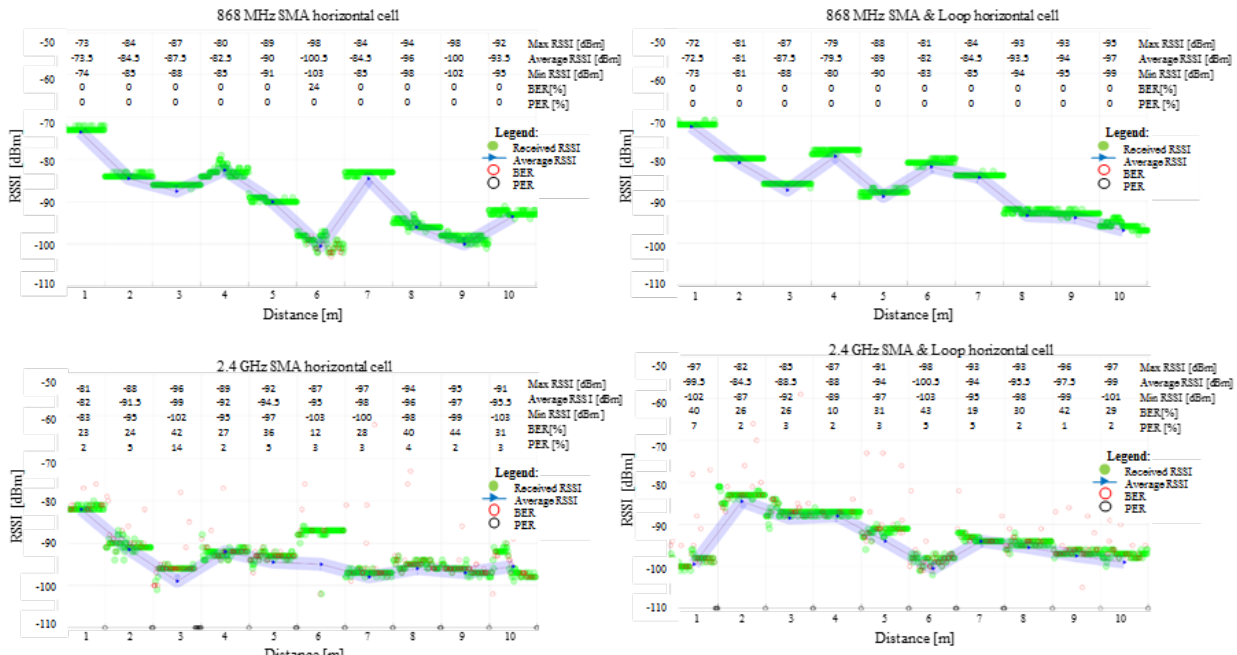
Figure 8. Experimental measurements received signal strength indicator (RSSI), bit error rate (BER) and packet error rate (PER) for 868 MHz and 2.4 GHz communication over the 1 m up to 10 m separation between the two RF transceivers. The radiative cell’s shell is in horizontal orientation towards the ground plane.